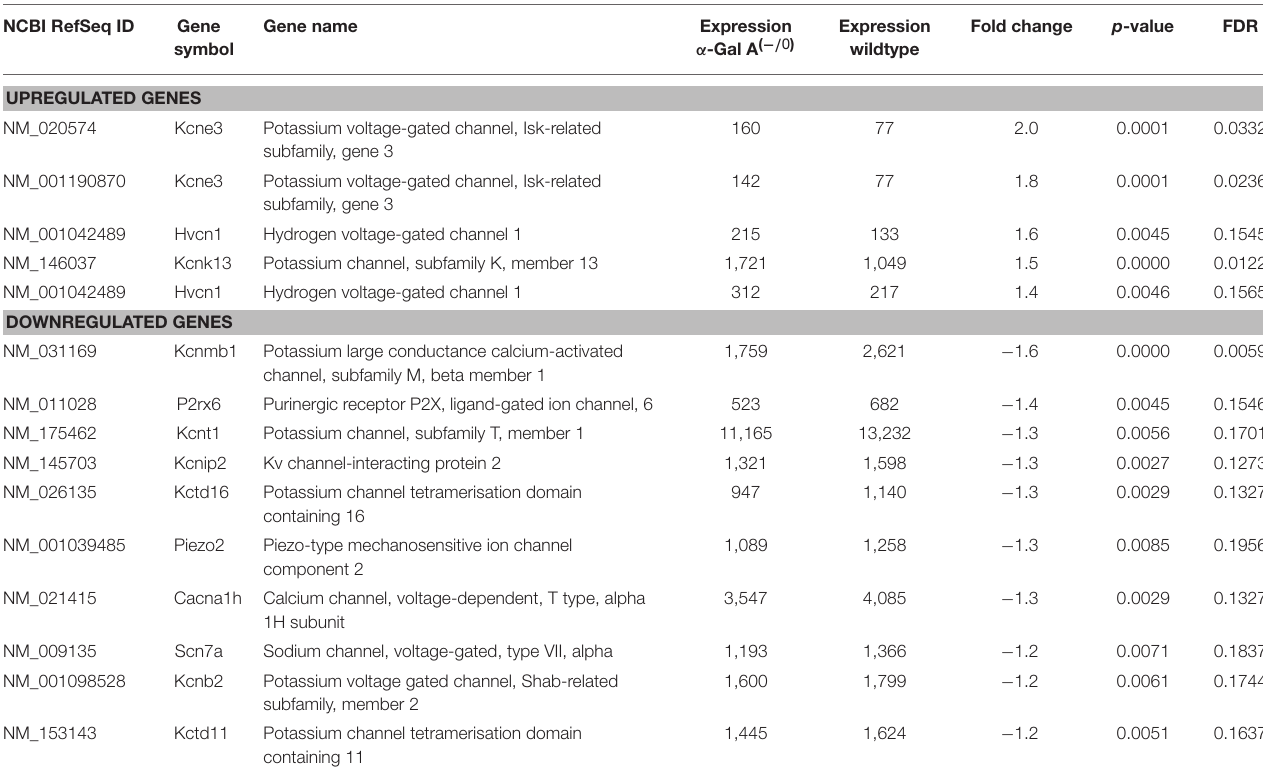
TABLE 7 | Raw expression values, fold changes, and statistical analysis for significantly regulated ion